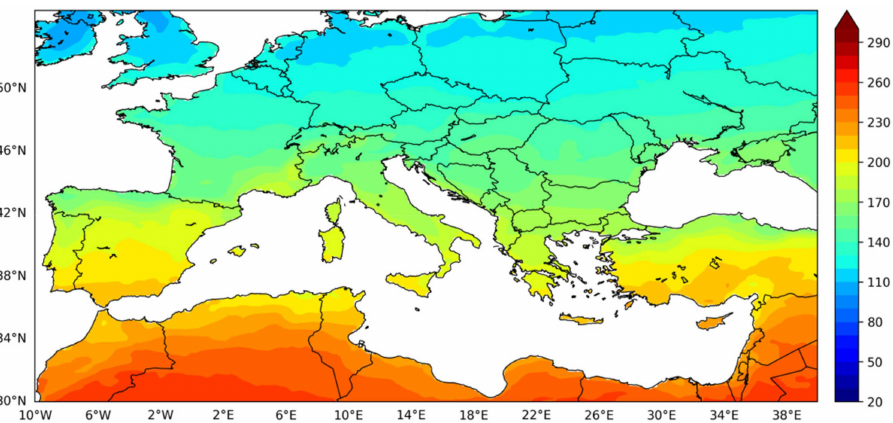
Figure 8. Mean annual SWGI (W/m 2 ) over Euro-Mediterranean region from ERA5-Land calculated for the period